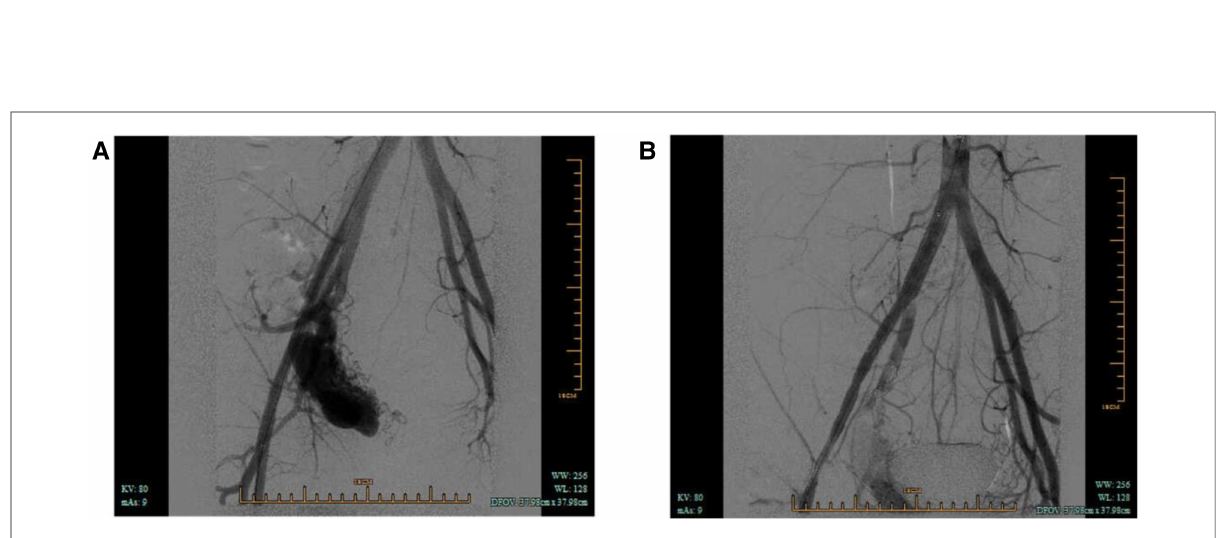
FIGURE 3 ( A ) Arteriography demonstrated pelvic arteriovenous malformation and feeding arteries arising from the right internal iliac artery. ( B ) Arteriography